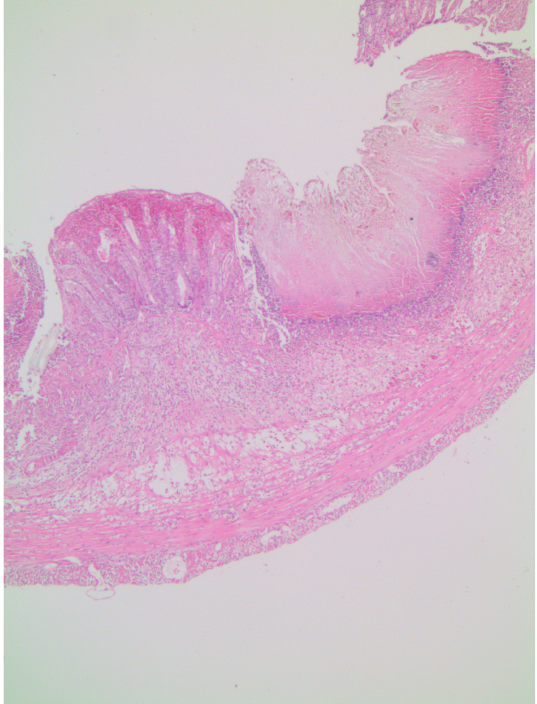
Figure 5. Combined group on day 3, edema, necrosis, and congestion (H&E, × 40). H&E, hematoxylin and eosin. inflammation observed (Figure 1), on day 7, the inflam- mation regressed and regenerative changes appeared (Figure 2). In TNBS and combined groups, on days 3 and 7, there was focal ulceration fields and transmural inflammation (Figures 3-6).